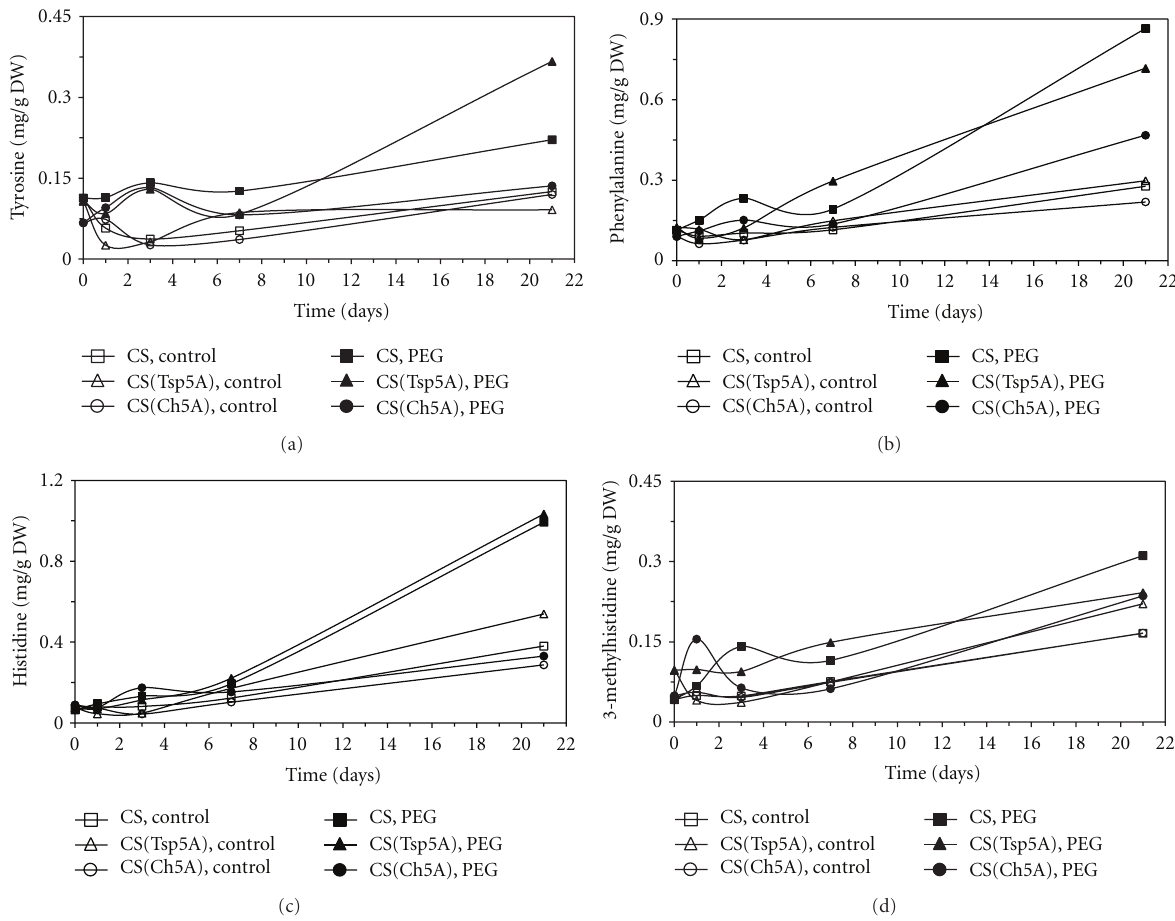
Figure 8: E ff ect of osmotic stress on the concentration of amino acids belonging to the aromatic amino acid family. The time course of changes was compared under control and stress (15% PEG) conditions in the freezing-sensitive CS and CS(Tsp5A) and the freezing-tolerant CS(Ch5A) wheat genotypes. The standard deviations of the data were below 10% in each case (not shown on the graphs because of the better transparency). (a): Tyr (SD: 0.046), (b): Phe (SD: 0.091), (c): His (SD: 0.122), and (d): 3-metil-His (SD: